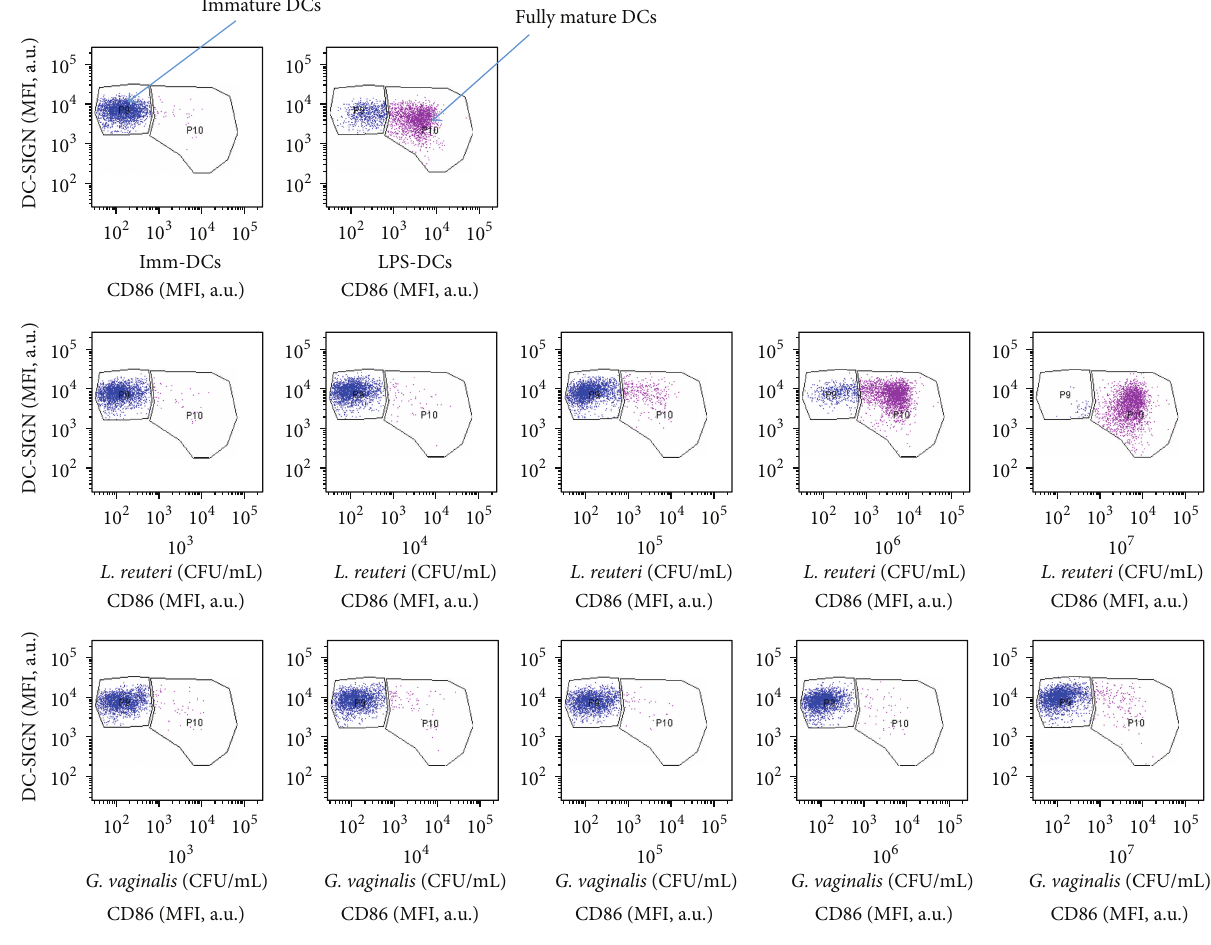
Figure 2: Surface phenotype of human DCs after exposure to a range of G. vaginalis or L. reuteri concentrations. The dot plots and histograms show MFI values on gated DCs. DC-SIGN/CD86 dot plots gated on human DCs. Data from a representative experiment comparing G. vaginalis -induced DC process of maturation with that induced by L. reuteri